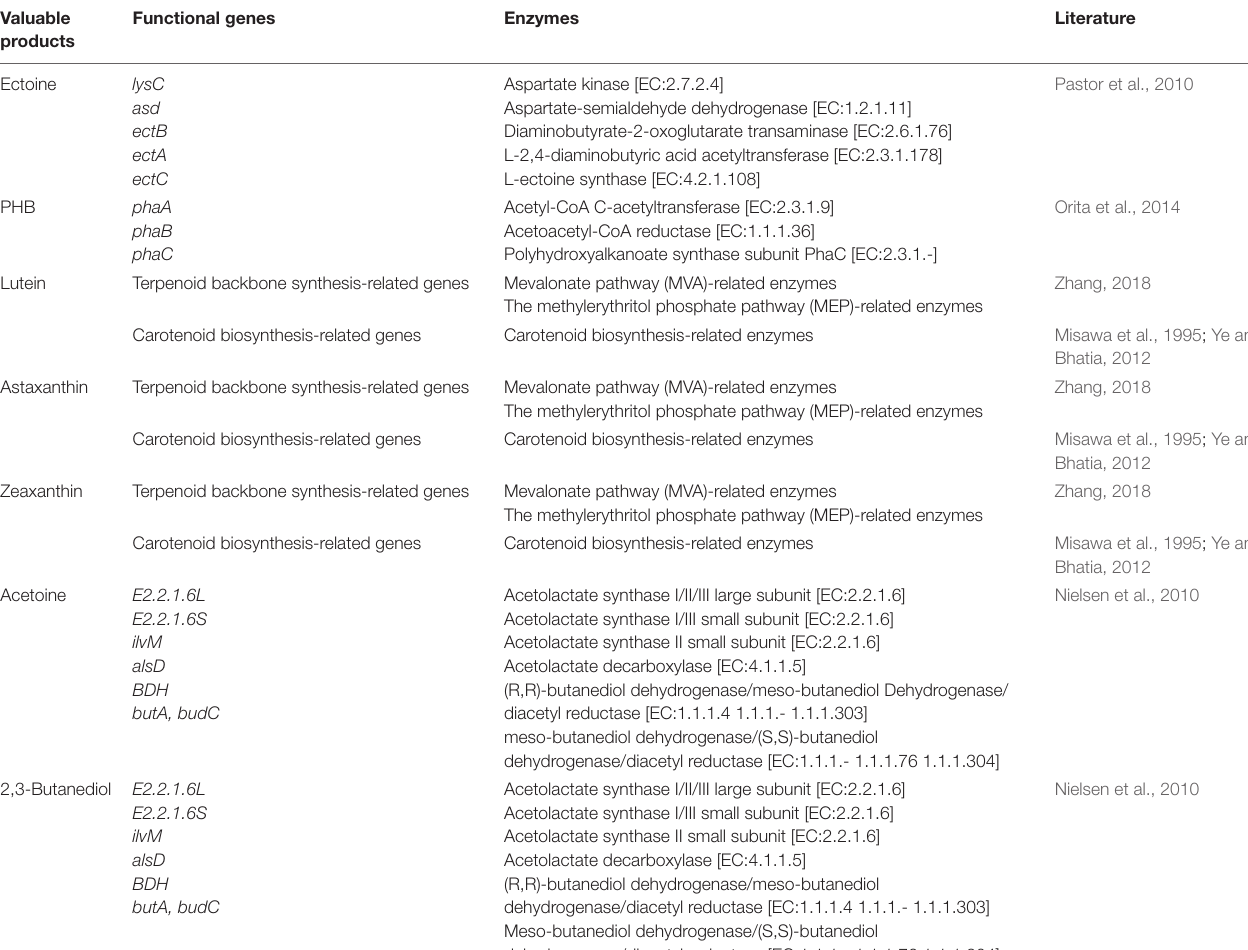
TABLE 3 | Functional genes and enzymes related to production of valuable products. The functional genes of the metabolic pathways, consist of terpenoid backbone synthesis and carotenoid biosynthesis, are shown in Supplementary Table 1 . Valuable